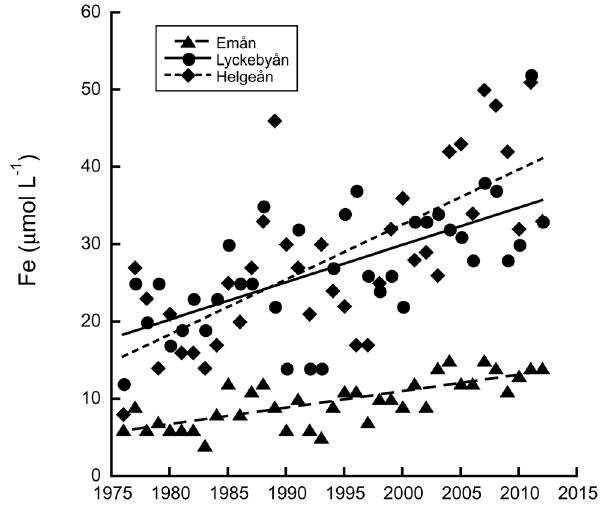
Figure 1. Yearly mean iron concentrations in the river mouths of three different rivers from 1976–2012. Lines denote the linear regression equations, which were m mol Fe L 2 1 =0.212 6 year – 413.2 (r 2 =0.56, p , 0.001); m mol Fe L 2 1 =0.477 6 year – 924.0 (r 2 =0.40, p , 0.001); and 0.716 6 year – 1398.4 (r 2 =0.51, p , 0.001) for Ema˚n, Lyckebya˚n and Helgea˚n